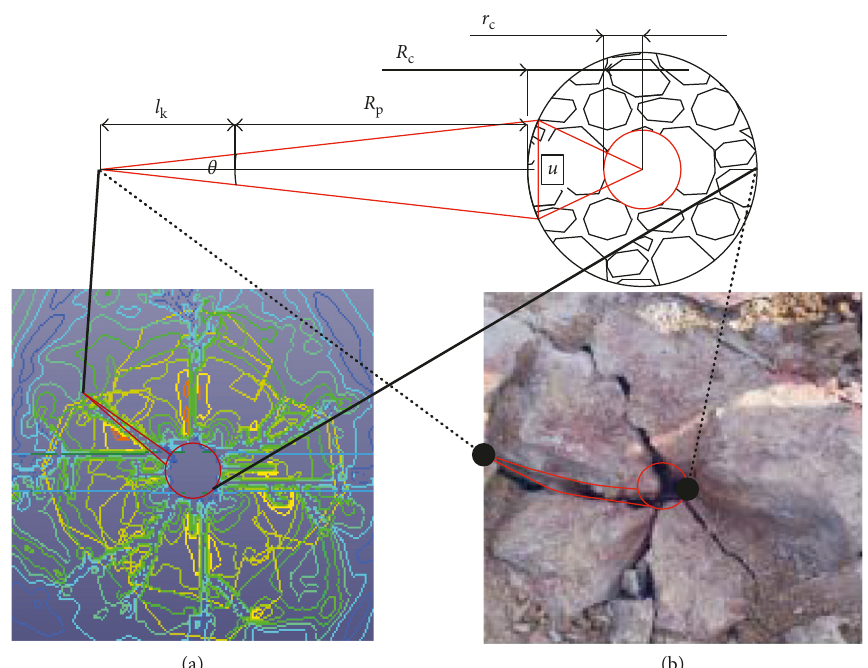
Figure 2: Plan view of the tip of a single initial crack. (a) Numerical simulation. (b) Field